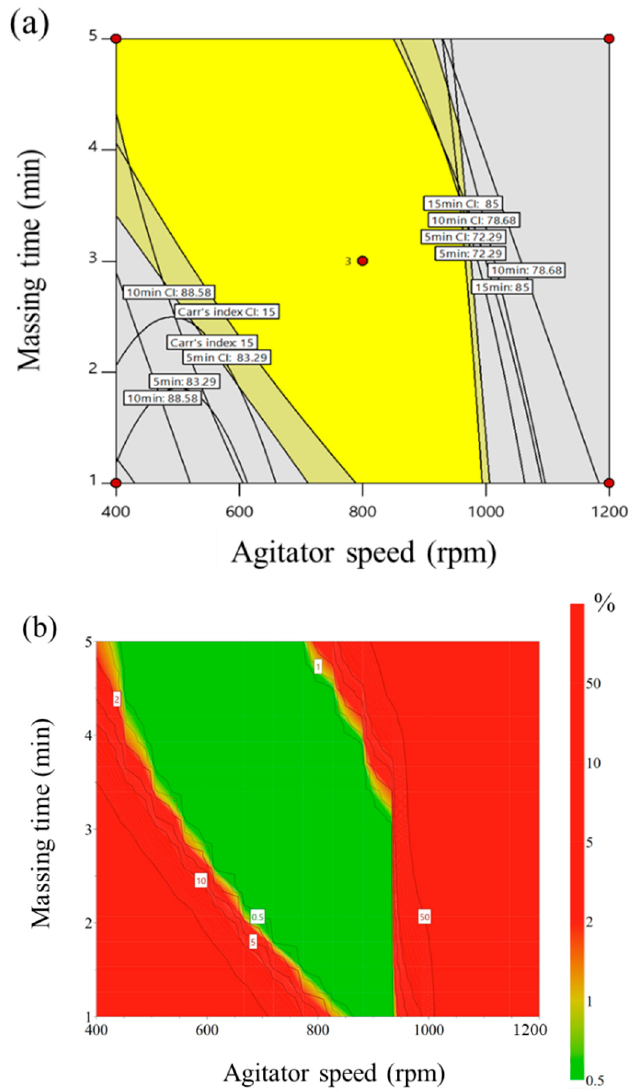
Figure 4. ( a ) Operating spaces (overlay plot) to optimize process parameters of high-shear wet granulation for the telmisartan test tablet. The yellow area is the operating space with 95% confidence intervals. (b) Monte Carlo simulation results for the operating space. The green area shows a quality certainty of 99.9. Table 4. Optimal process parameters, target values, and validated results at the lab scale for the